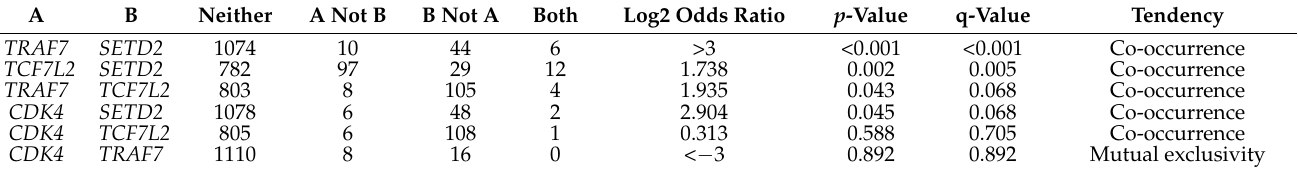
Table 4. Interactions of the regulatory elements with the other transcription